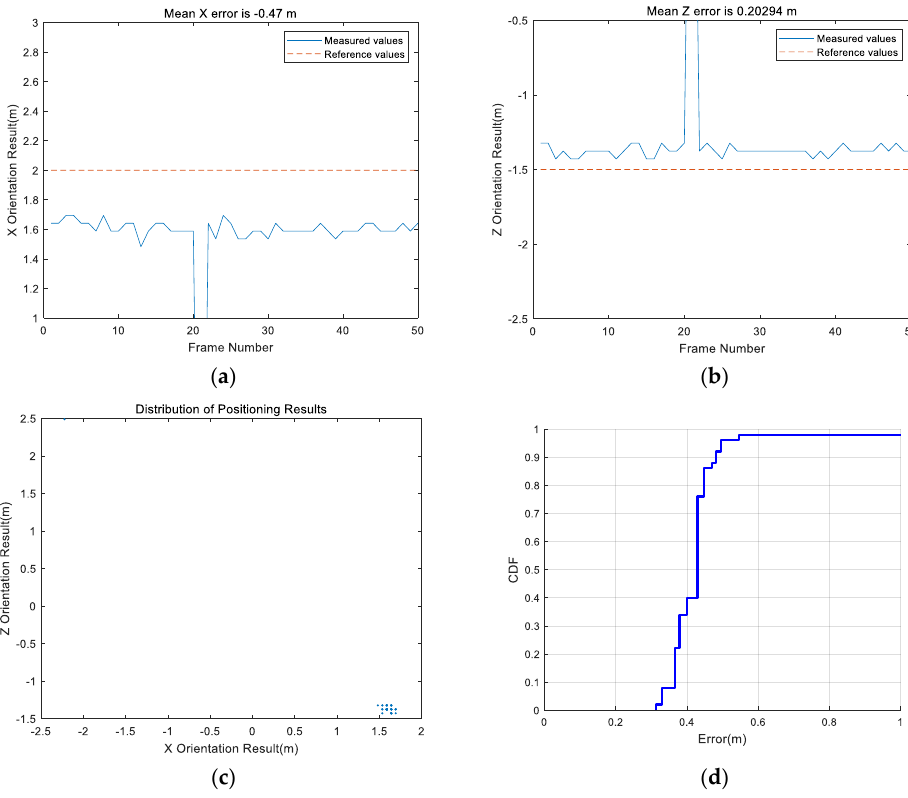
Figure 9. The static test location results for the source location of (2, −1.5). ( a ) Average error in the x–direction. ( b ) Average error in the z–direction. ( c ) Location distribution. ( d ) CDF.